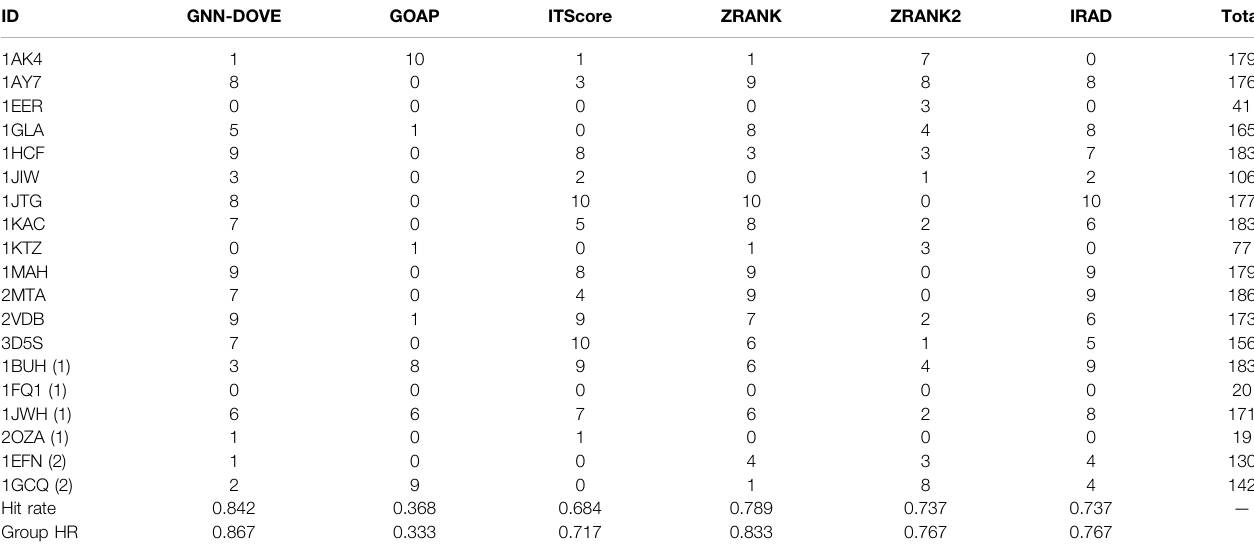
TABLE 3 | Performance on the Dockground+ZDOCK testing dataset.